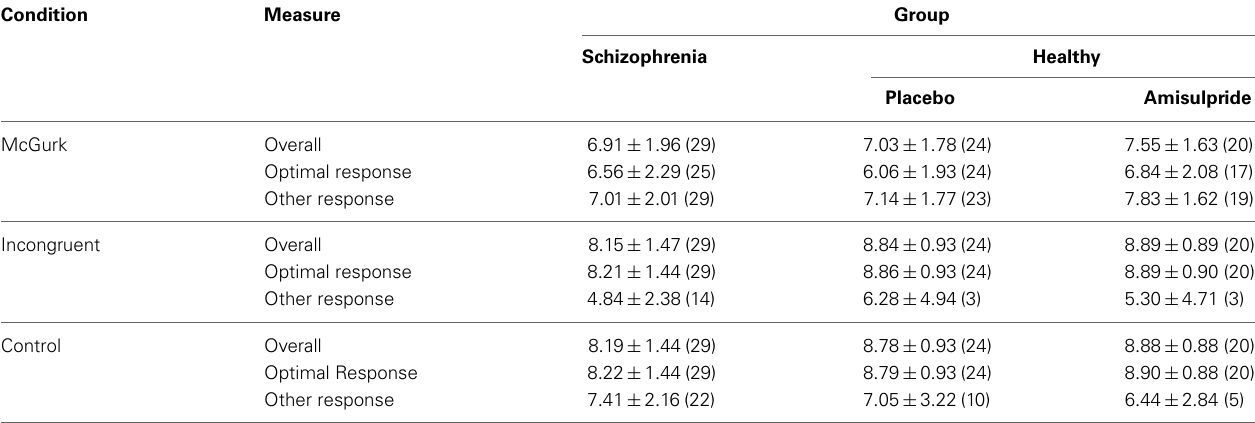
Table 3 | Confidence ratings categorized by experimental condition and